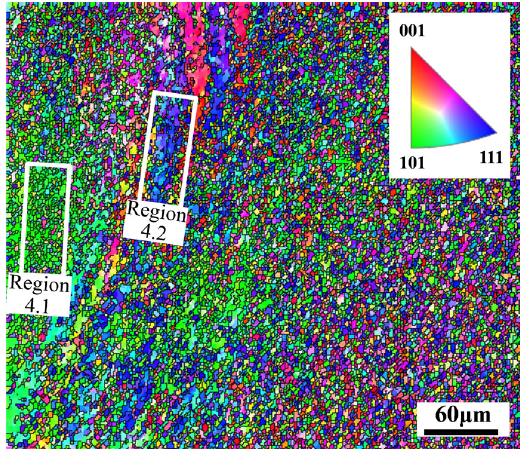
Figure 11. EBSD images of grain morphology in Region 4.